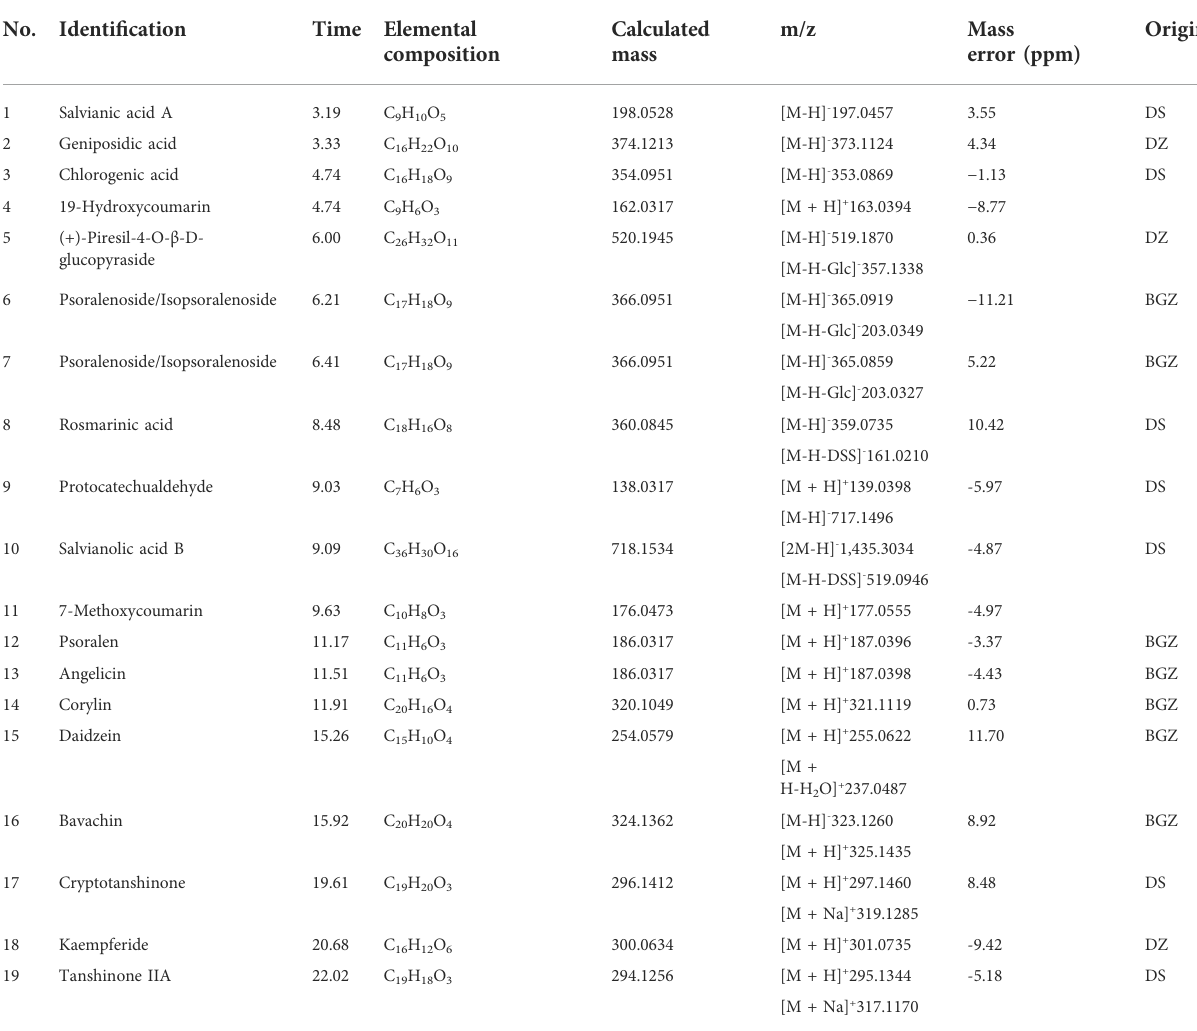
TABLE 1 Chemical constituents identi fi ed of Modi fi ed Qing ’ e Formula (MQEF) extracts. No. Identi fi